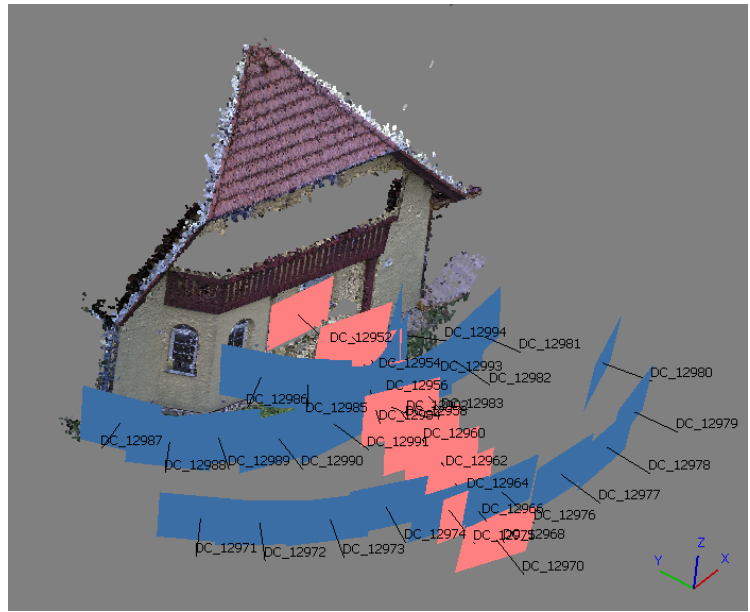
Figure 11. Capturing scenario of the experiment; 10 perpendicular images are highlighted.